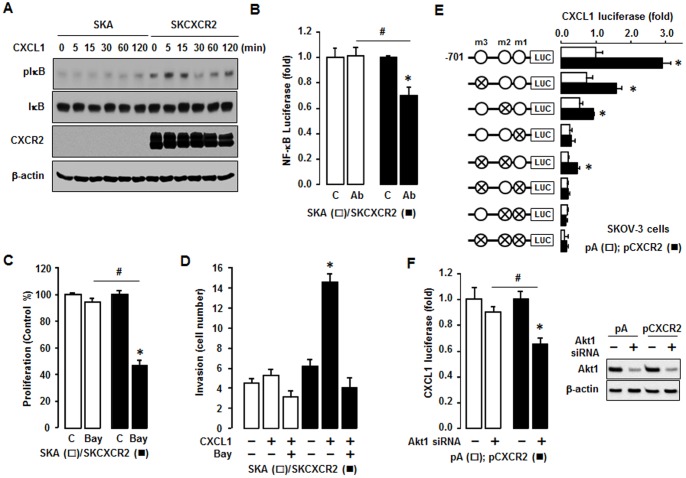
CXCL1 enhances NF-κB activation and CXCR2 increases CXCL1 promoter activity via NF-κB site.(A) Comparative effects of CXCL1 on NF-κB activation in SKA and SKCXCR2 cells. Cells were treated with CXCL1 (100 ng/ml) and results examined in a time-dependent manner. Whole cell lysates were prepared and Western blots carried out using antibodies specific to IκB, phosphorylated IκB (pIκB) and CXCR2. β-actin was used as a loading control. (B) Effect of CXCL1/2/3 antibody on NF-κB luciferase activities in SKA and SKCXCR2 cells. After transfection using the NF-κB luciferase vector overnight, cells were incubated with normal IgG (C) and the CXCL1/2/3 antibody (Ab, 1∶100 dilution)) for 4 h. (C) Effect of Bay11-7082 on cell proliferation in SKA and SKCXCR2 cells. Cells in A-B were incubated with vehicle (C) or Bay11-7082 (Bay, 2 µM) for 48 h. The cell proliferation assay was performed using MTT and values were normalized to untreated controls. * and # in 5B and 5C (p ≤ 0.05) when compared to Control (C) and SKA cells, respectively, by the paired Student’s t-test. (D) Inhibitory effects of Bay11-7082 (2 µM) on CXCL1-induced cell invasion in SKA and SKCXCR2 cells. * (p≤0.05) when compared to Control (C) and SKA cells, respectively, by the paired Student’s t-test. (E) Effect of CXCR2 on luciferase activity of mouse CXCL1 promoter in parental SKOV-3 cells. Site-directed mutants were generated from the KC701LUC using primers with mutant κB sites (termed m1, m2 and m3 indicates mutation site): −615/−585 mutant κB site (KC701LUCm3), −102/−71 mutant κB site (KC701LUCm2) and −83/−52 mutant κB site (KC701LUCm1). Additional mutants of κB sites were generated as KC701LUCm3m2, KC701LUCm3m1, KC701LUCm2m1, and KC701LUCm3m2m1. After transfection with CXCL1 luciferase vector overnight, a luciferase assay was performed. Results were normalized to the activity of internal control (pRL-TK vector) and expressed as a fold increase compared to empty vector (pA) controls. * (p≤0.05) when compared to its own control by Student’s t-test. Cross circles indicate κB site mutants. pA  =  empty vector transfection; pCXCR2  =  CXCR2 vector transfection. (F) Effect of Akt1 siRNA on CXCL1 promoter activity in parental SKOV-3 cells with empty vector or CXCR2 transfection. After transfection with CXCL1 luciferase vector and siRNAs for control and Akt1 (final concentration: 10 nM) overnight, a luciferase assay was performed. Results were normalized to total protein concentrations and expressed as a fold increase compared to each control. All experiments were performed at least in triplicate and all data are shown as mean ± S.E. * and # (p ≤ 0.05) when compared to Control siRNA and pA transfected cells, respectively, by Student’s t-test. We confirmed knockdown of Akt1 (main Akt isoform in parental SKOV-3 cells) by using Akt1 siRNA. Whole cell lysates were prepared and a western blot was carried out using Akt1 specific antibody. β-actin was used as a loading control.